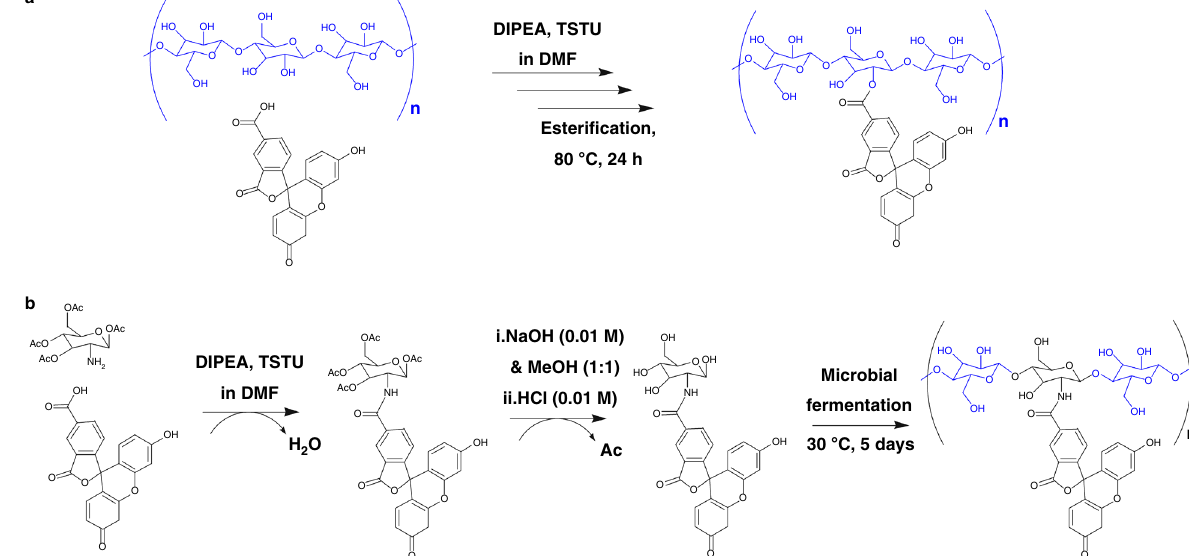
Fig. 1 Chemical and biological preparation of functional BC. a Chemically modi fi ed BC (Ch-6CF/BC) was prepared by soaking neat BC in activated 6CF solutions for 30 min at room temperature under inert conditions and drying at 80 °C. b The 6-carboxy fl uorescein-glucose (6CF-Glc) was fi rst synthesized starting from 6-CF and 1,3,4,6-tetra-O-acetyl-2-amino-2-deoxy- β -D-glucopyranose, and it was then used as a carbon source to produce functionalized 6CF-BC through microbial